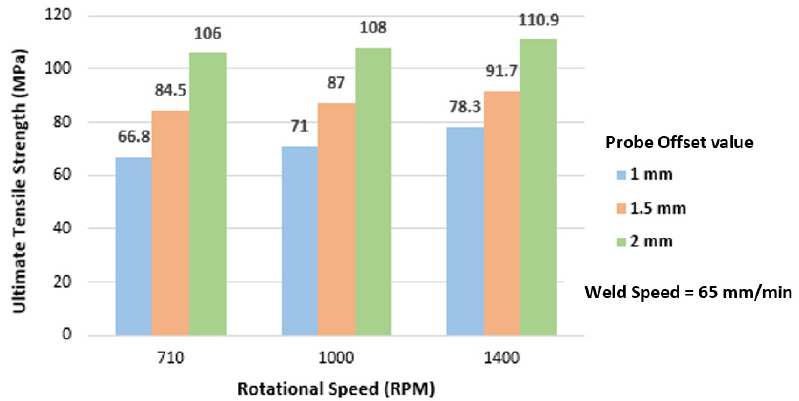
Figure 11. UTS of weld joint with different probe offset values.